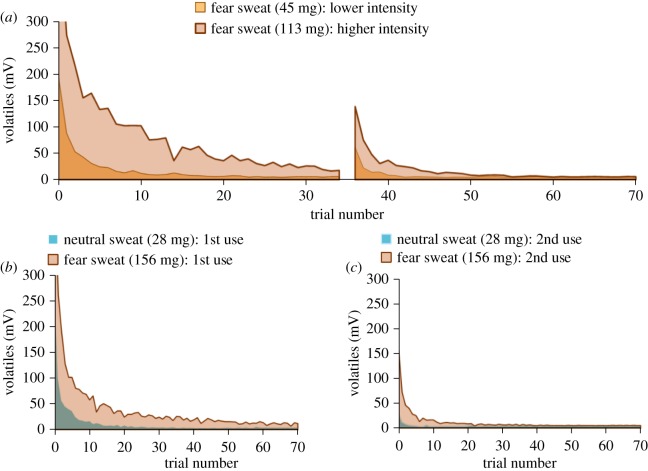
Quantity of volatiles emitted by sweat (expressed in mV) as a function of time, pad weight and emotion. (a) Higher intensity fear sweat emits more volatiles than lower intensity fear sweat. A mid-way break caused volatiles to build up in the headspace, producing temporarily higher values. (b) Fear sweat emits more volatiles than neutral sweat. (c) Reused sweat (second use) emits fewer volatiles than first time used sweat (first use). (Online version in colour.)